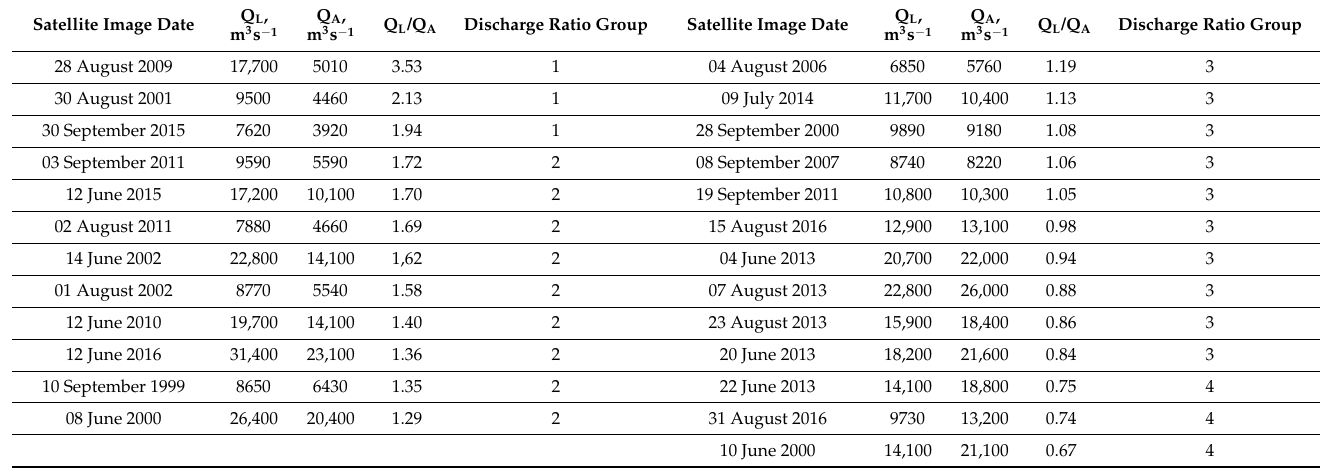
Table 7. The ratio of water discharge in the Lena River ( Q L ) to the flow in the Aldan River ( Q A ).